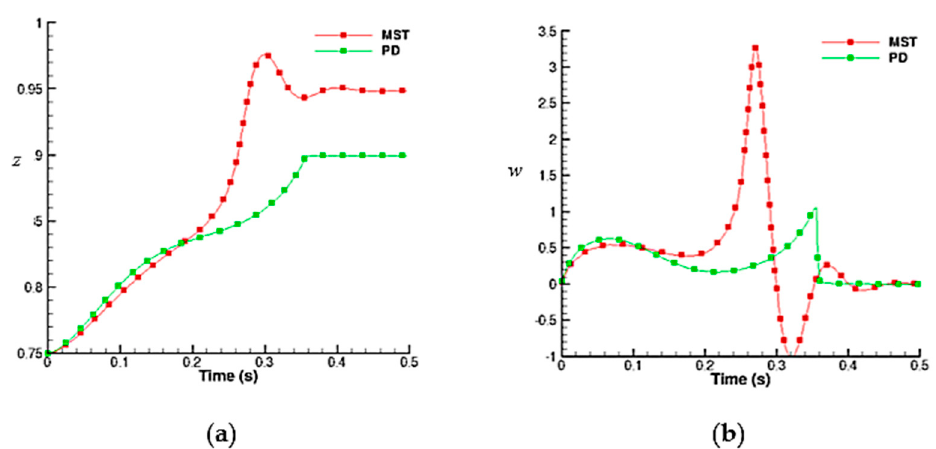
Figure 10. The z -components of the second particle position ( z ) and velocity ( w ) for the PD and MST methods are shown as functions of time. a = 0.1 and ε p = 1.5. The initial positions of the particles are (0.25, 0.25, 0.75) and (0.75, 0.25, 0.75). ( a ) z , ( b ) w . The dimensionless parameters are the same as in Figure 5.